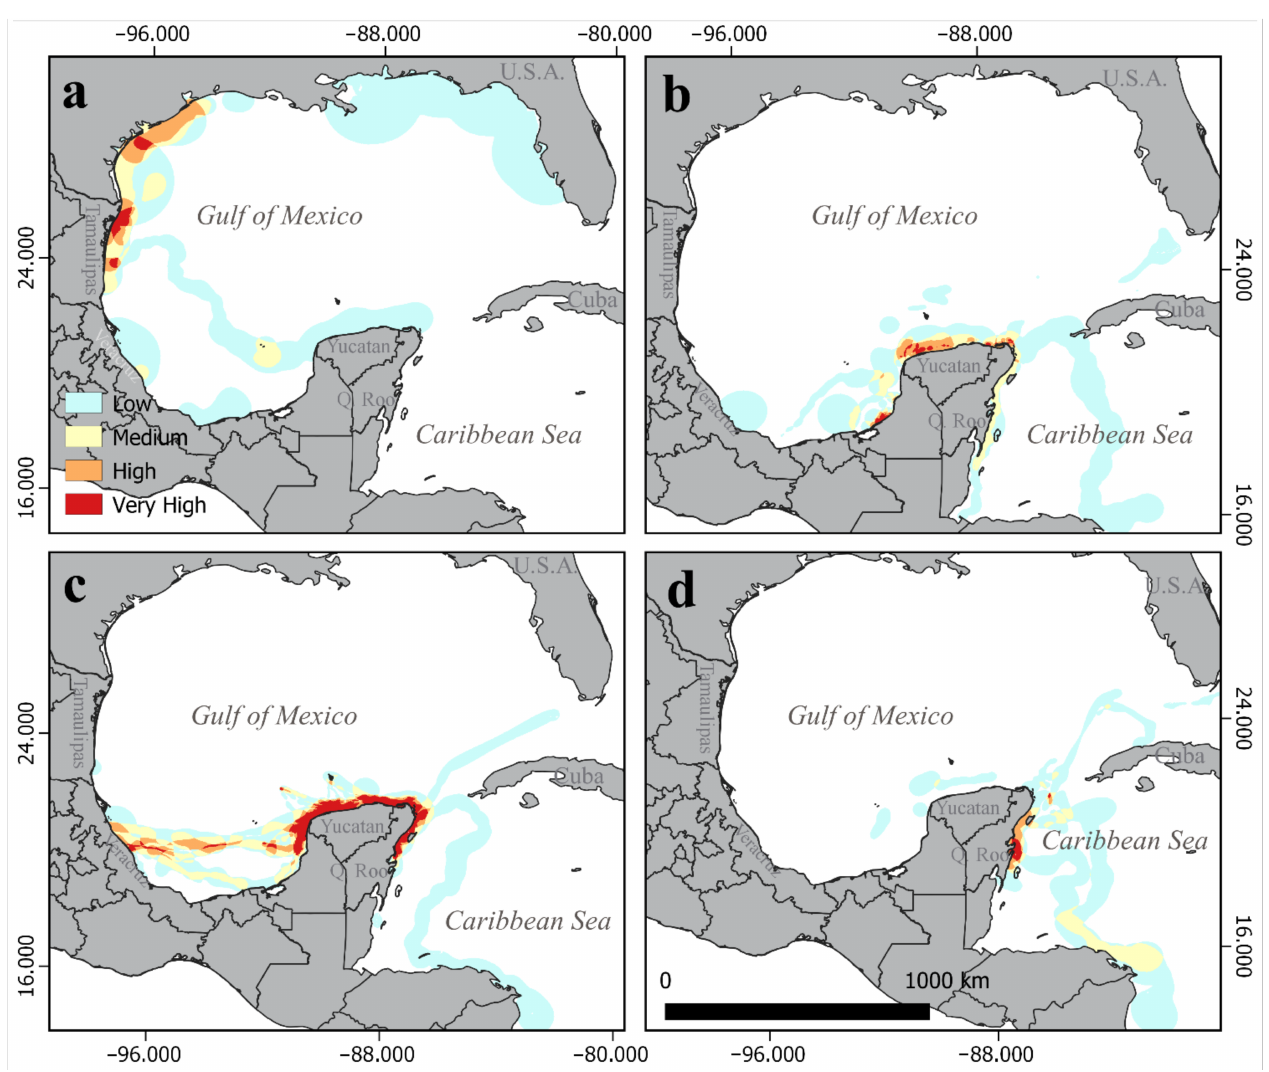
Figure 4. Use intensity of migratory corridors for adult reproductive females of Kemp’s ridley ( a ), hawksbills ( b ), green ( c ) and loggerhead ( d ) turtles nesting on the Atlantic coast of Mexico. The color scale is based on the use intensity that in this case alludes to the number of individuals that used the